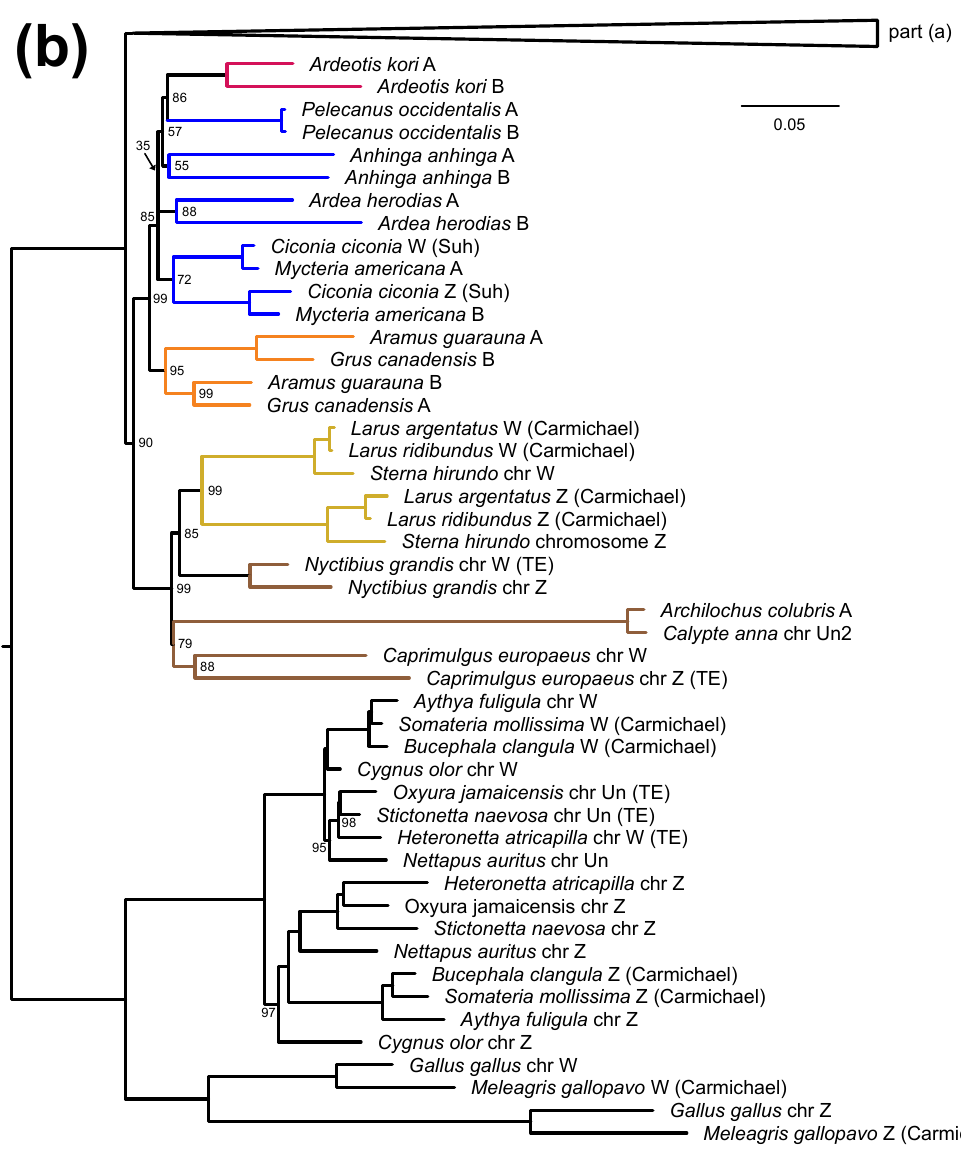
Figure 3. Maximum likelihood estimate of the ATP5F1A gene tree from 50 samples (representing 49 species based on the IOC world bird list v. 11.2 [49]). Samples collected using PCR and cloning as part of this study have A or B following the species name (since we could not a priori assign gametologs to the Z or W chromosome). Species names followed by “chr” and then Z, W, or Un are from the chromosomal-level genome with the designation (Z, W, or unplaced) based on annotation in NCBI. If this is followed by “TE” the sequence contained a transposable element insertion. Species names followed by Z or W and then either Carmichael et al. [41] and Suh et al. [22] are from those published studies with the Z and W designation determined by those authors. Colors identify major clades, and are those used in Braun and Kimball [66]. ( a ) Sequences from many species in Neoaves, including all Passeriformes; ( b ) remaining Neoaves and all Galloanserae.